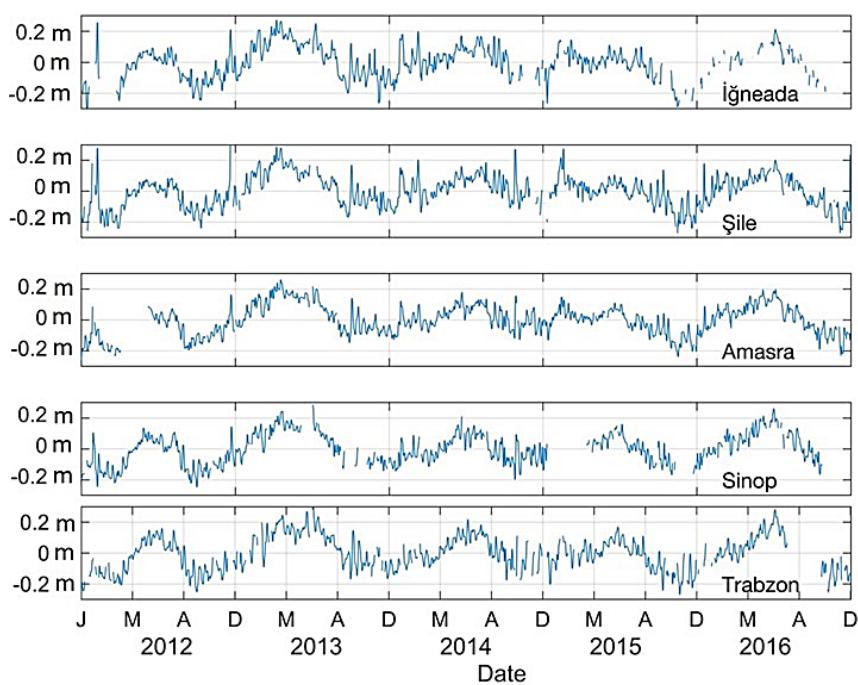
Figure 2. Time series of hourly sea level in meters from ˙I˘gneada, ¸Sile, Amasra, Sinop, and Trabzon from 2012 to 2017. The data have been smoothed using the robust linear regression method of the MATLAB smoothdata function with the rlowess